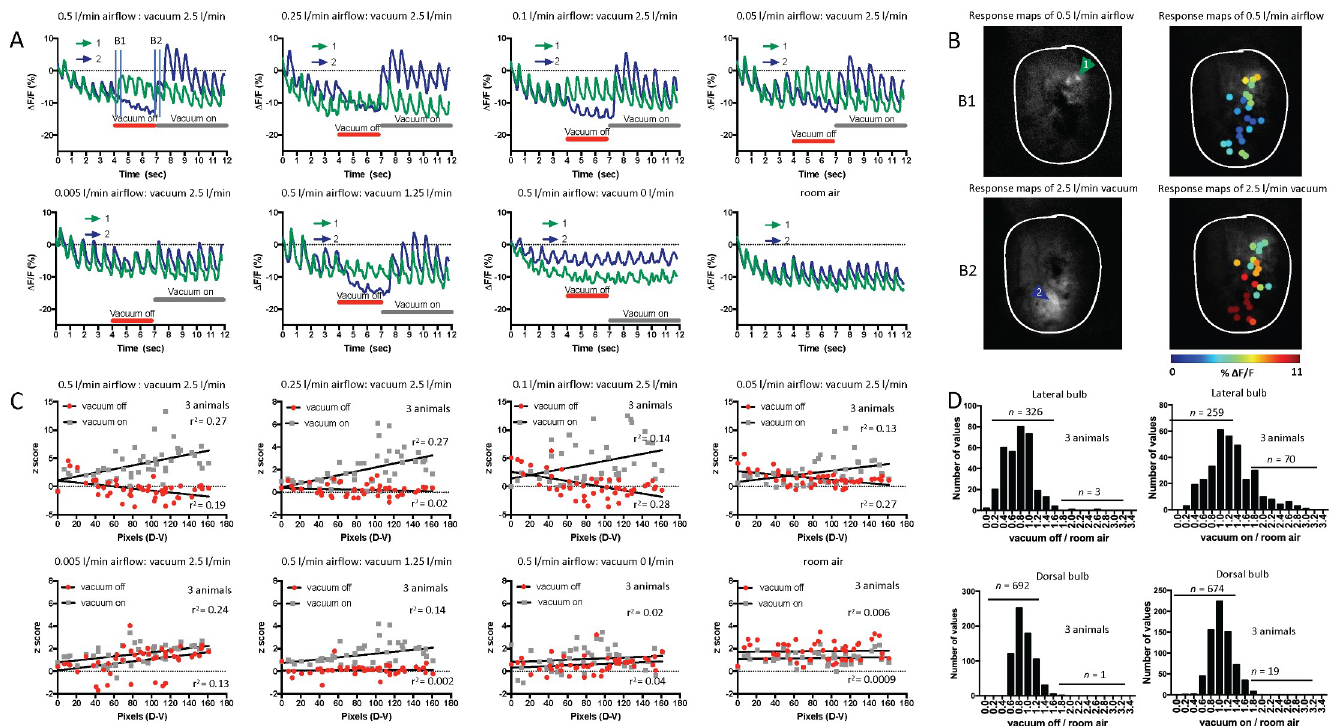
Fig 5. The lOB displays mechanosensitive activation beyond breathing. (A) Raw traces (% Δ F/F) of two glomerular breathing responses during presentation of clean air flow rates (0.5, 0.25, 0.1, 0.05, and 0.005 L/min) and vacuum rates (2.5, 1.25, and 0 L/min) and room air with no external flows (1 animal, 2 glomeruli). These are presented as examples of the trial stimulus; green represents a glomerulus in the dorsal region of the lOB, blue in the ventral (maps shown in panel B). Red bar illustrates the period in which only the air is presented (“Vacuum off”), and grey is when the vacuum is also turned on (“Vacuum on”); height indicates flow rates relative to other trials. Vertical blue bars indicate response and reference frames to compute response maps. (B1, vacuum off response; B2, vacuum on response; maps shown in panel B). (B) Activation map in response to inspiration during only clean air flow rate of 0.5 L/min (Left top) and additionally the vacuum 2.5 L/min (Left bottom). Arrows indicate the ROI displayed in panel A. B1 and B2 indicate the respective time points in panel A (0.5 L/min airflow: vacuum 2.5 L/min). Right: activation map of all glomeruli chosen to clean air flow rate of 0.5 L/min (Top) and vacuum 2.5 L/min (Bottom). (C) The z-scores of the lOB glomerular responses during only clean air flow (red) and also vacuum (grey), organized from dorsal to ventral, for different clean air flow rates (0.5, 0.25, 0.1, 0.05, and 0.005 L/min) and vacuum rates (2.5, 1.25, and 0 L/min) and room air (3 animals, 47 glomeruli). Linear correlation fits are indicated. (D) Top left: histogram of the ratio of vacuum off responses relative to room air breathing responses in the lateral bulb. Top right: histogram of the ratio of vacuum on breathing responses relative to room air breathing responses in the lateral bulb (3 animals, 47 glomeruli, total 329 glomerular responses across all flow rates). Number of responses ( n ) was divided into number of glomerular responses < 1.6 and > 1.6 times above the room air breathing response. Bottom: same as top but in the dorsal bulb. Underlying data for this figure can be found in S1 Data. lOB, lateral olfactory bulb; OB, olfactory bulb; ROI, region of interest.